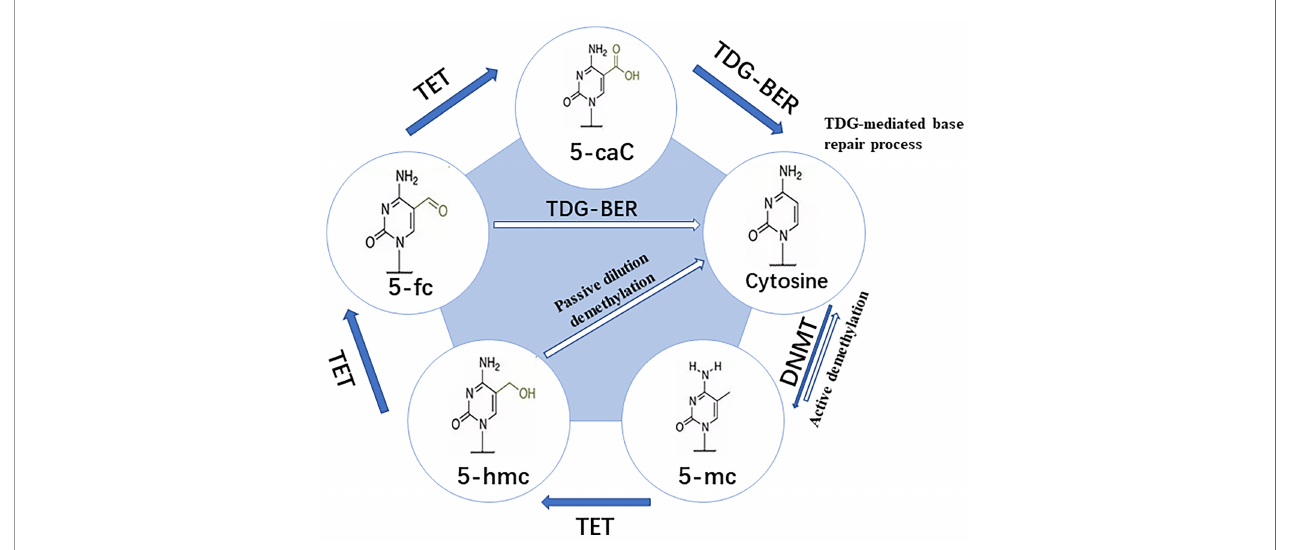
FIGURE 2 | Pathway for dynamic modi fi cations of cytosine. Methylation is achieved by DNMTs transferring the methyl to unmodi fi ed cytosine. It involves two steps: (A) Passive dilution, in which the methyl is directly removed to yield unmodi fi ed cytosine; and (B) Active demethylation, in which the methyl is catalyzed by TET into different oxidized forms and then combined with glycosylation, base repair, DNA replication, and other methods to yield unmodi fi ed cytosine